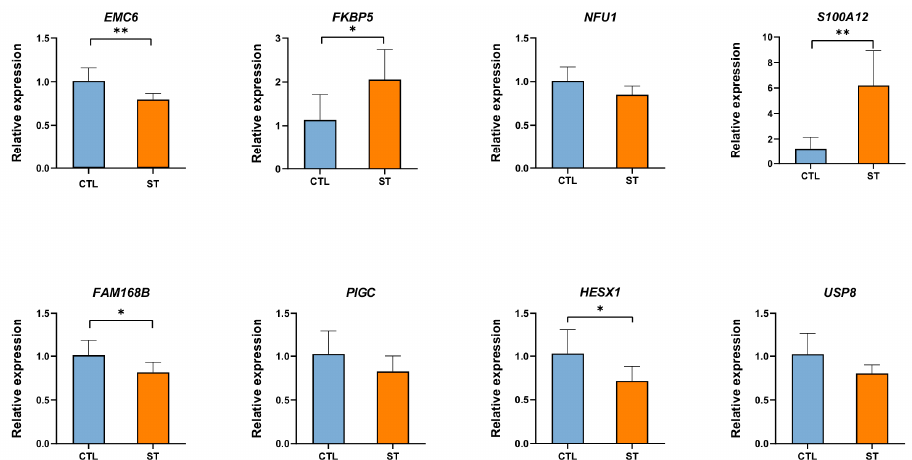
Figure 9. Expression levels of selected candidate genes from cecum tissues of Dagu chickens non- infected and ST-infected 24 h post-infection. CTL refers to the chickens from the non-infected group, while ST corresponds to the ST-infected chickens. Six birds were used per group. Data were analyzed using Student’s t -test. * p < 0.05, ** p < 0.01.